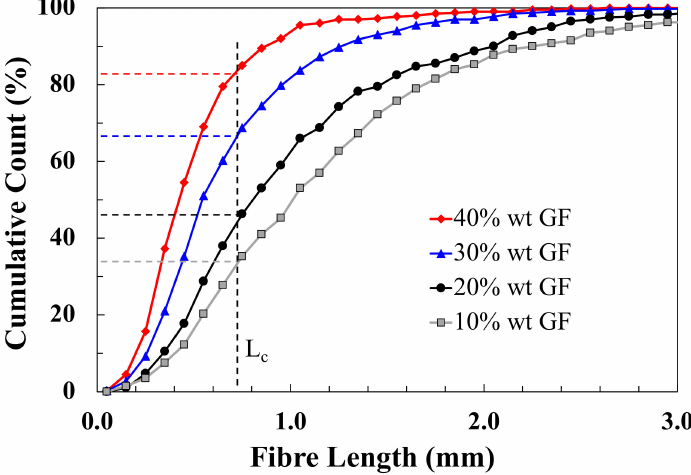
Figure 4. Some fibre length distributions in injection moulded GF-PP composites